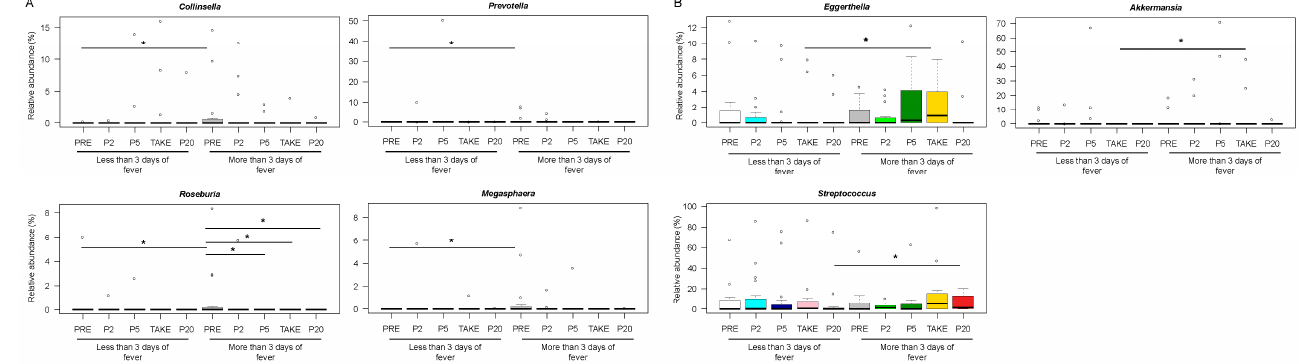
Figure 4. Early and late gut microbiota signatures of febrile neutropenia duration. Boxplots showing the relative abundance distribution of genera significantly differentially represented between patients with less than or equal to vs. more than three days of fever, before transplant ( A ) and after the onset of fever ( B ). PRE, before transplant; P2, at the onset of neutropenia (day − 2/+2); P5, at the onset of fever (day +4/+5); TAKE, at engraftment; P20, after engraftment (day +20/+30). Wilcoxon test, * for p < 0.05.